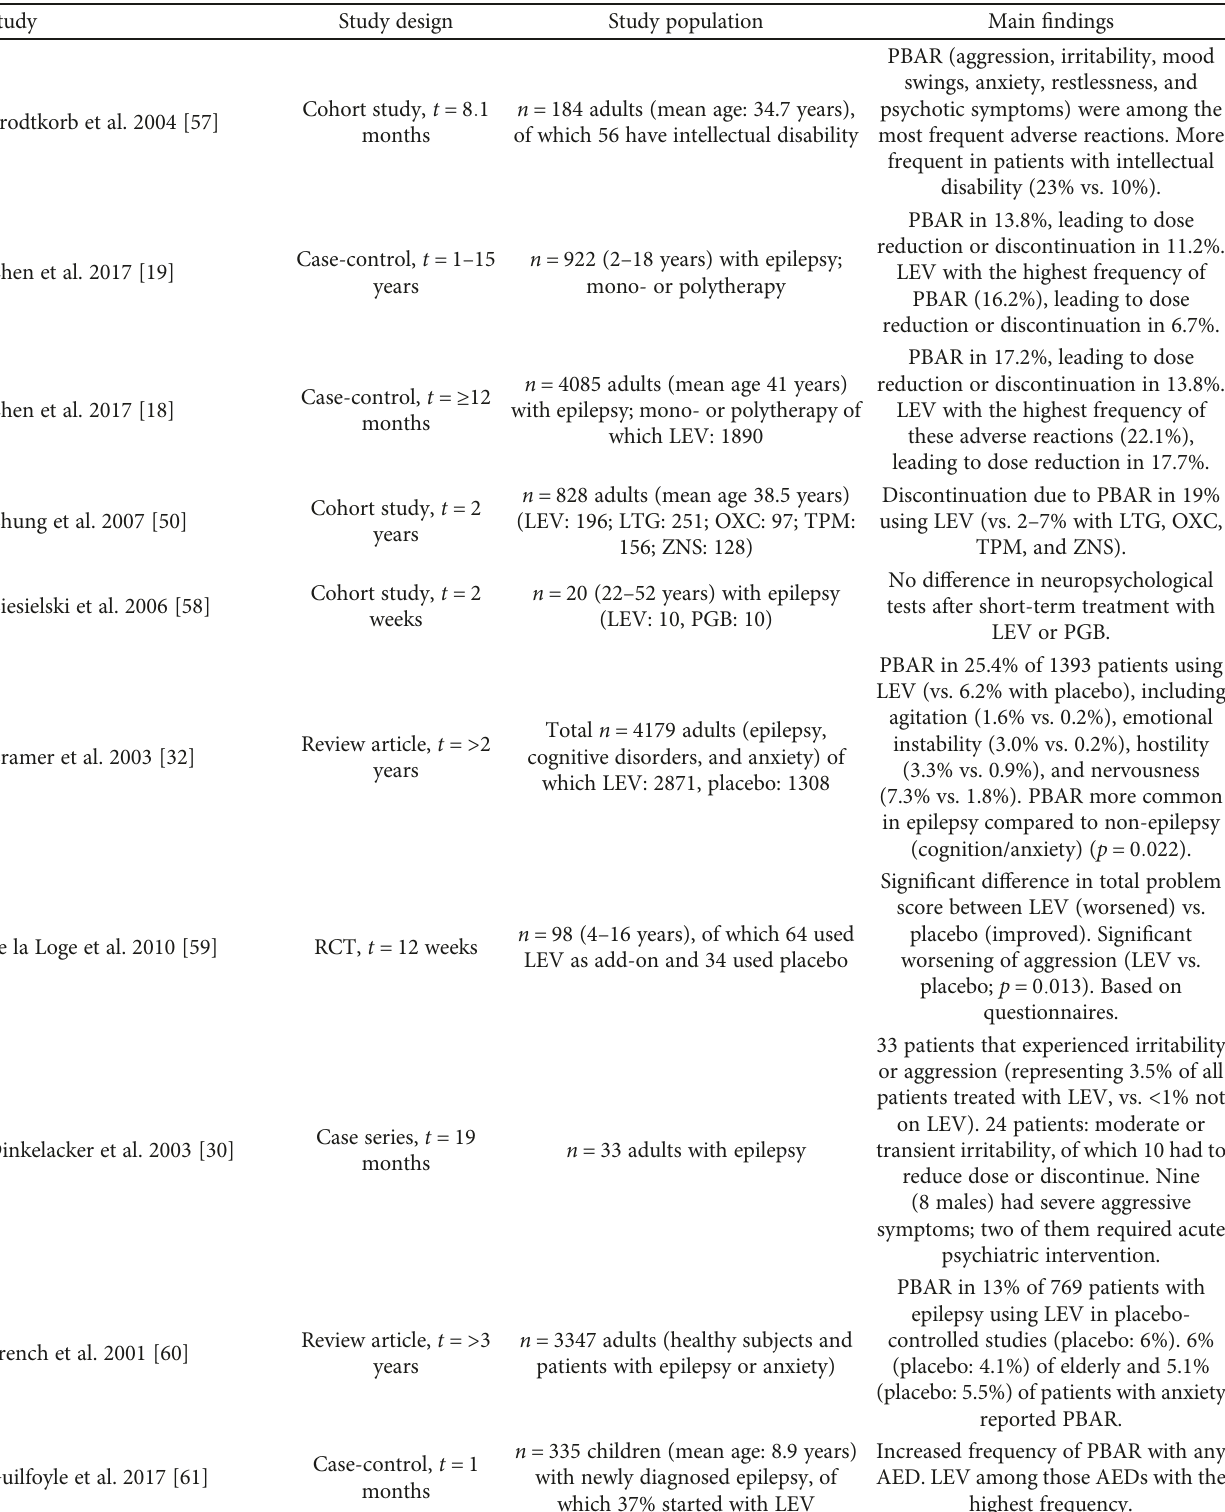
Table 2: Studies reporting psychiatric and behavioral adverse reactions to